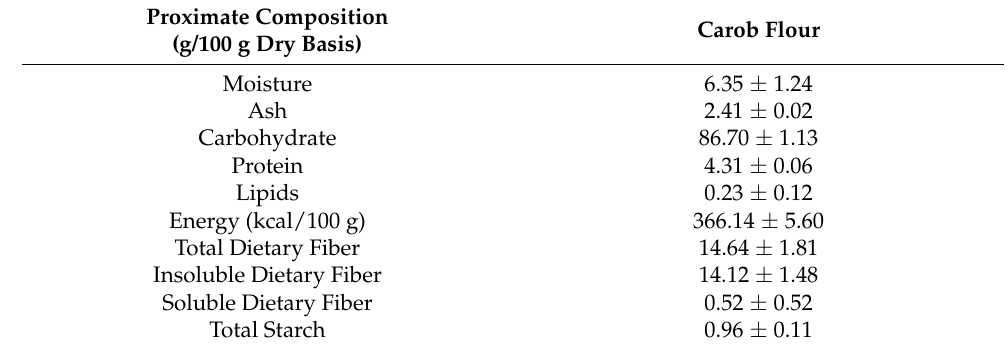
Table 1. Proximate composition of carob flour.